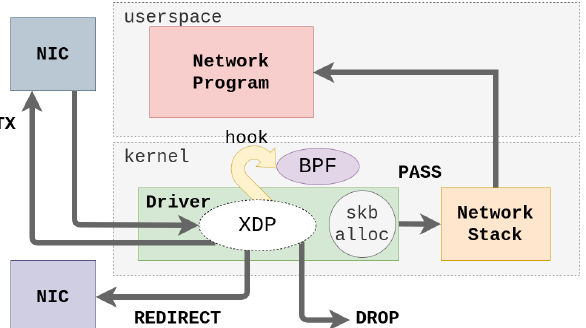
Figure 2. Simplified XDP architecture diagram with the possible actions that can be applied to the received packet before the socket buffer allocation by the operating system. Source: adapted from [14].